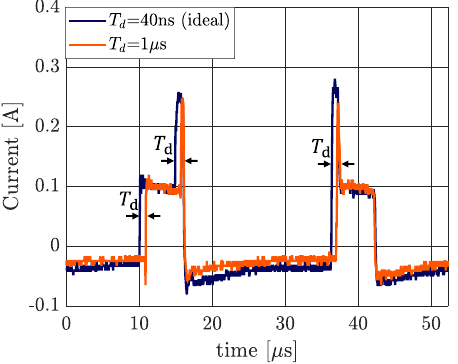
Figure 13. Example of the influence of dead-time to the delay in the capacitor current waveform of three-phase